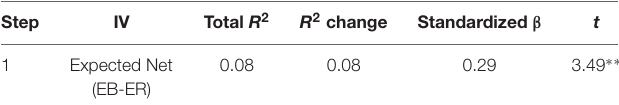
TABLE 4 | Hierarchical regressions predicting expected involvement in the cognitive appraisal of risky events. Step IV Total R 2 R 2